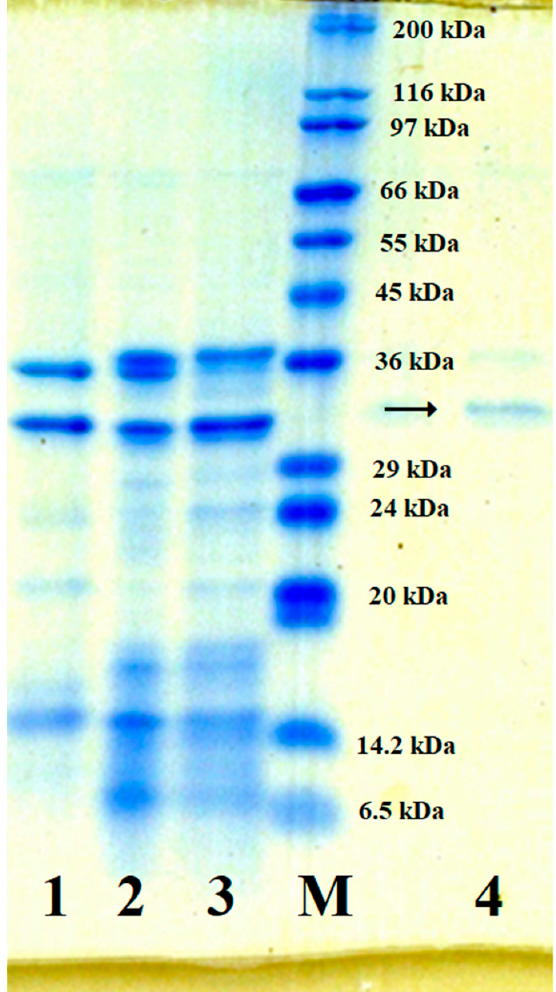
Figure 4. Sodium dodecyl sulfate-polyacrylamide gel electrophoresis (SDS-PAGE) profile of the TKU047 protease. M: Protein markers. 1 and 2: Crude enzyme after EtOH precipitation. 3: Adsorbed on Macro-prep High S column. 4: Purified enzyme after HPLC analysis on KW802.5 column. → : Purified enzyme.